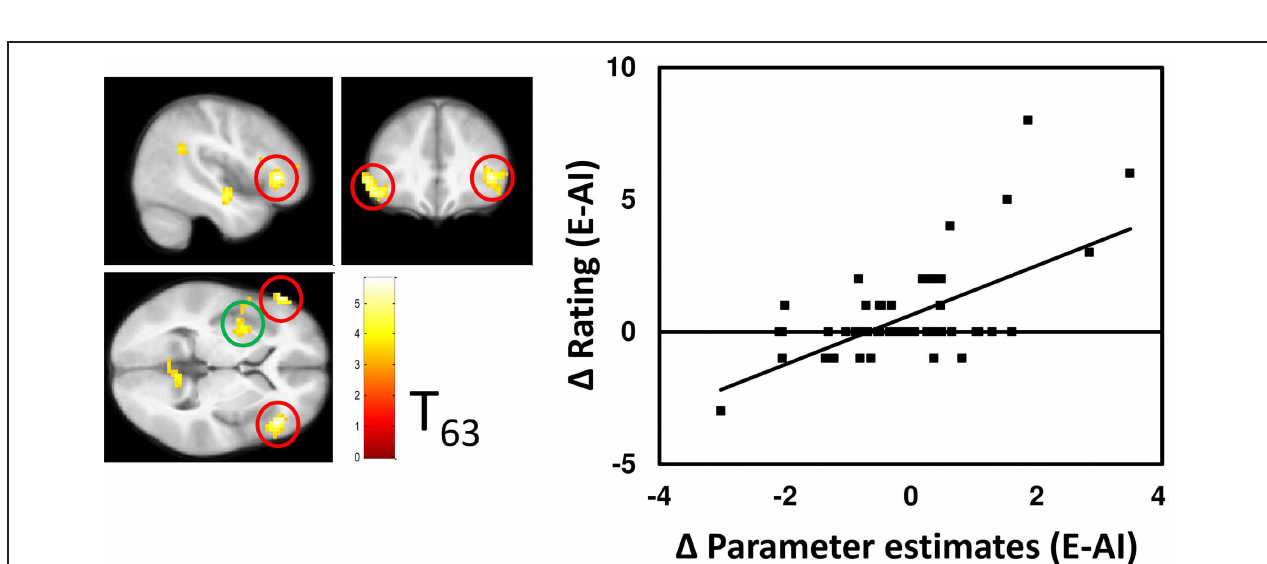
FIGURE 7 | Whole-brain analysis of the contrast DI > E. Left: Significant activation cluster (cluster corrected P FWE < 0 . 005, inclusion threshold P < 0 . 001 unc.) in the rDLPFC (Peak voxel MNI coordinates X = 48, Y = 29, Z = 37). The majority of the voxels lie in Brodman Area 9. Right: The bar plot